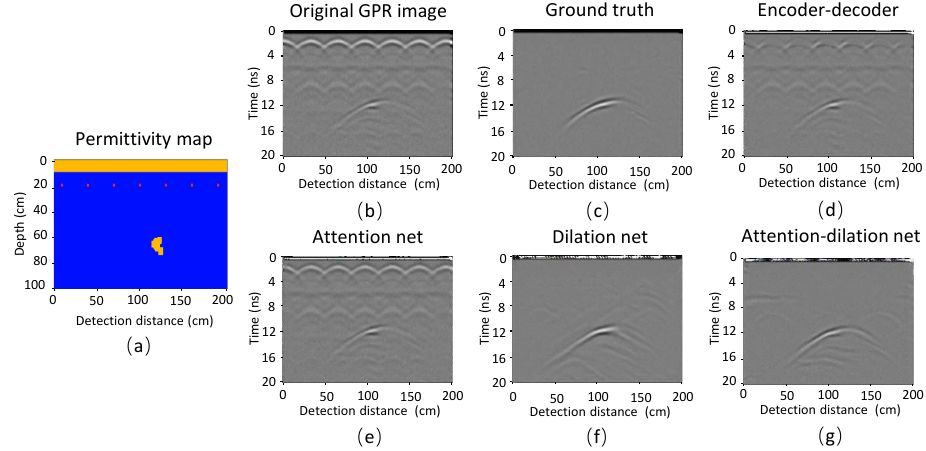
Figure 6. Processing results of RCE-GAN and its variants when the spacing between rebar is 30